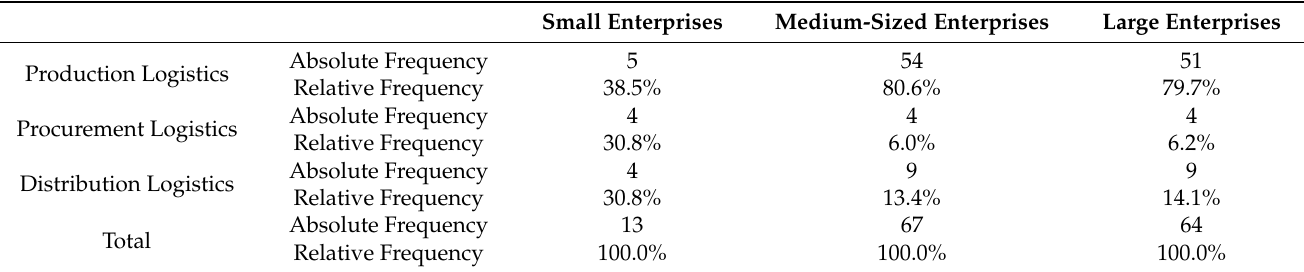
Table 5. Data file structure of Industry 4.0 implementation in various types of